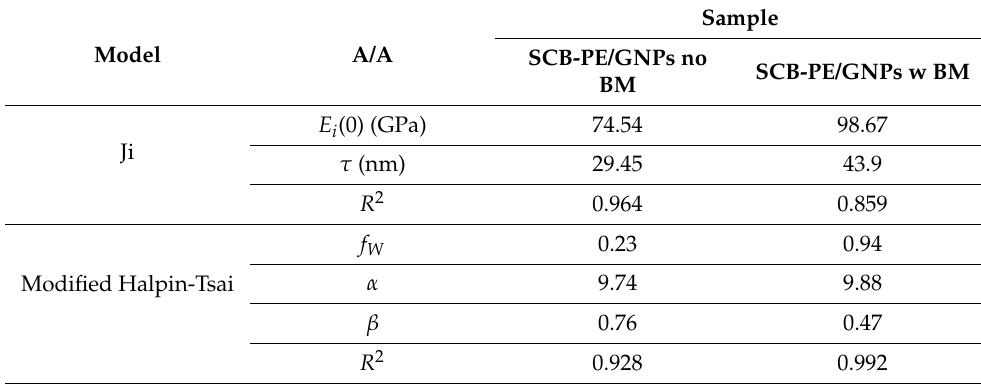
Table 3. Elastic modulus, tensile strength at yield and break, and elongation at break values of neat